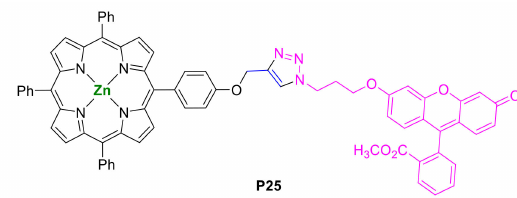
Figure 2. Structure of the porphyrin-fluorescein dyad P25